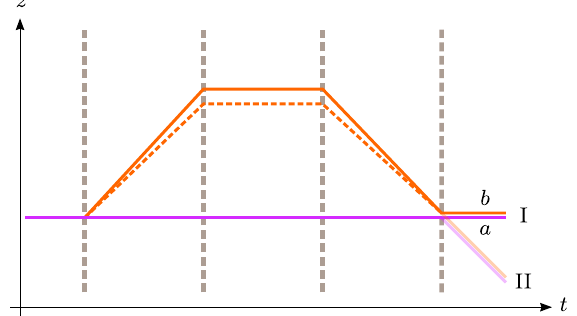
FIG. 5. The mass difference Δ m leads to a differential recoil for the two internal states. As a consequence, the central trajectories of the diffracted wave packets (orange lines) differ slightly for the ground state (continuous line) and the excited one (dashed